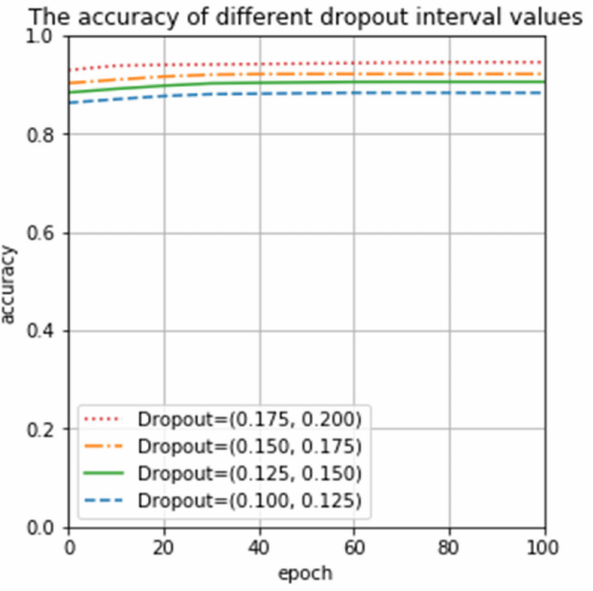
Figure 10. Accuracy in different intervals.